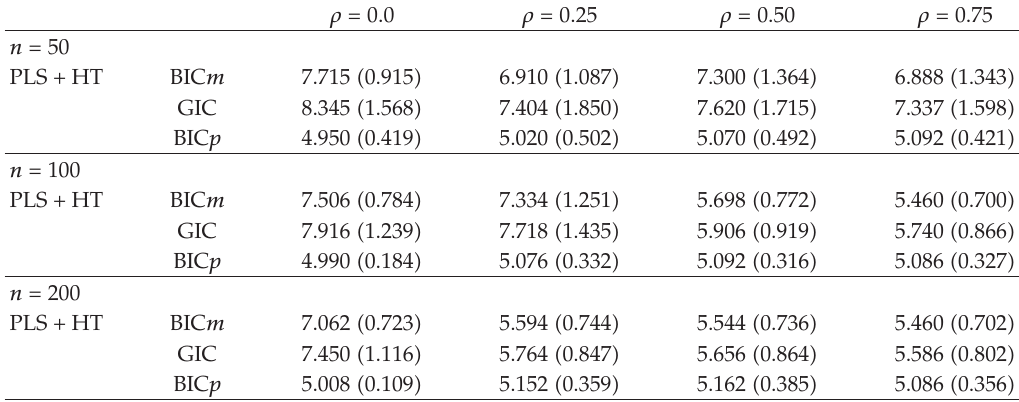
Table 6: Means (cid:3) standard deviations (cid:6) of the number of parameters excluded. ρ (cid:7) 0 . 0 ρ (cid:7) 0 . 25